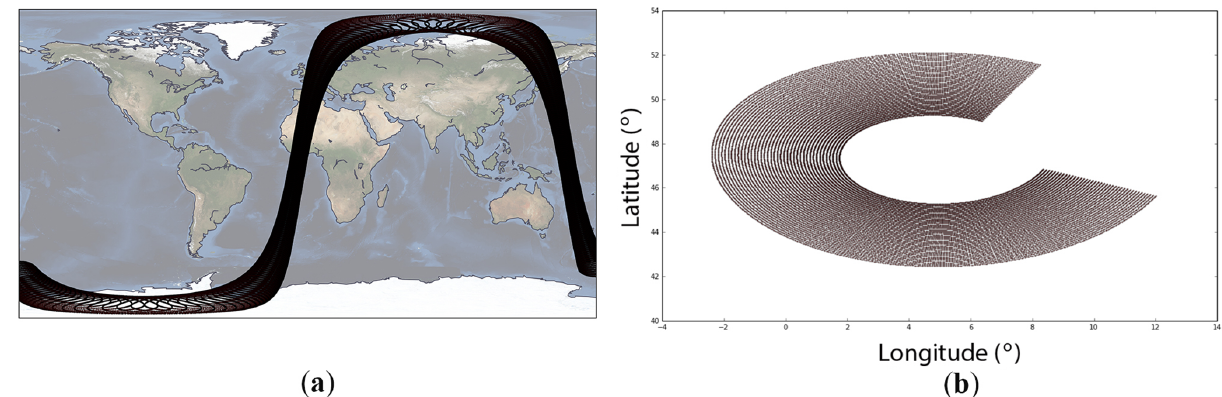
Figure 8. (a) One simulated satellite orbit for CFOSAT starting from 12 November 2011, with the circular motion of the slice located at the end of each pulse. (b) The zoomed-in location of all slices on the